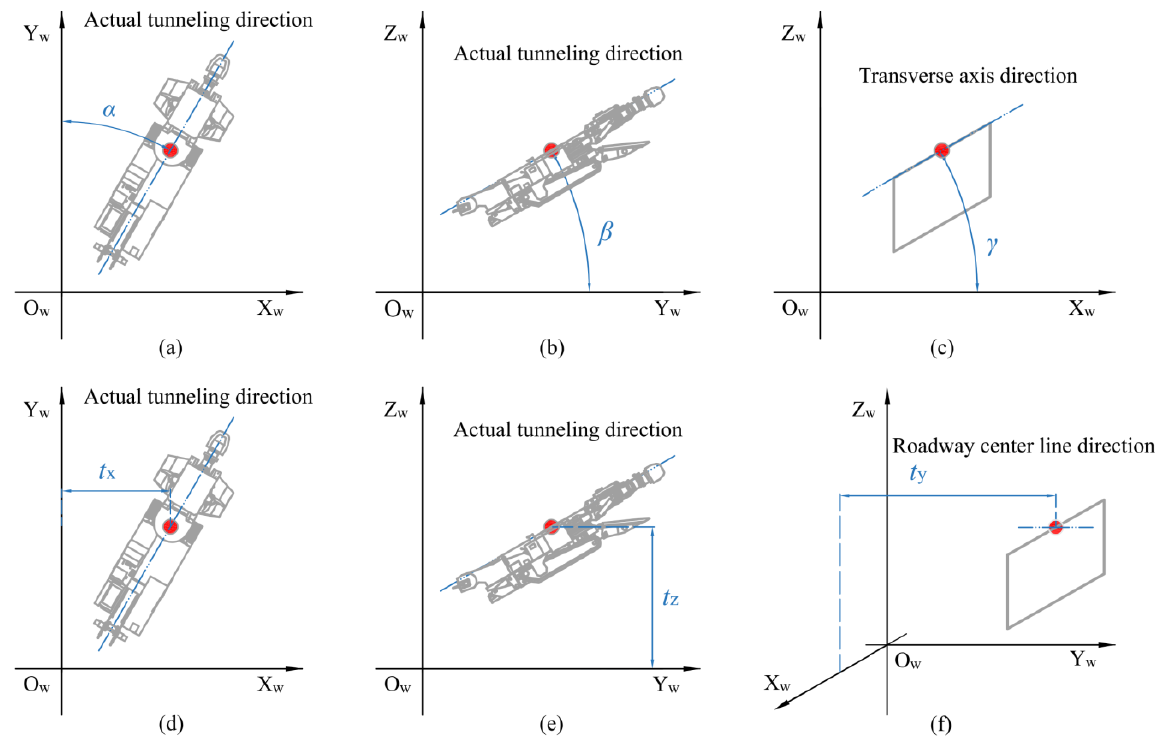
Figure 2. Pose parameters of roadheader body (camera).